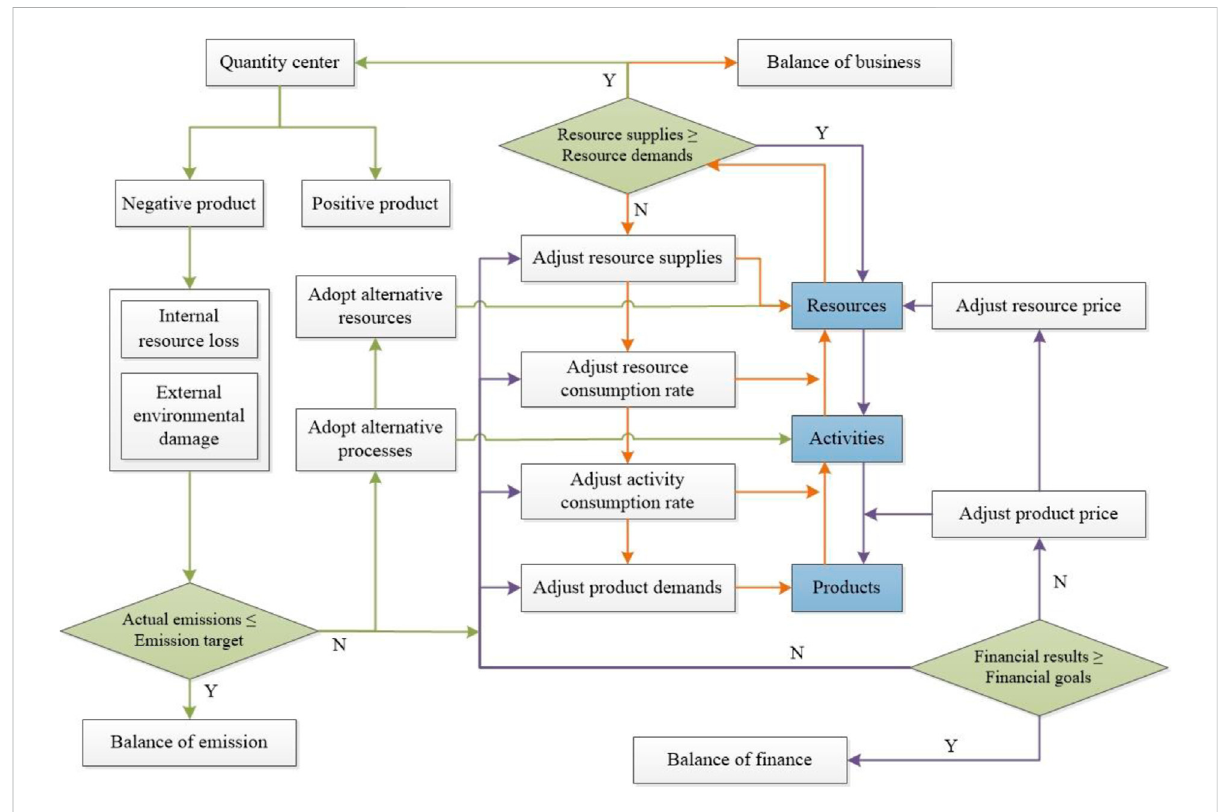
FIGURE 2 Model of MFCA-ABB. Note: In the fi gure, “ Y ” means “ Yes ” and “ N ” means “ No.